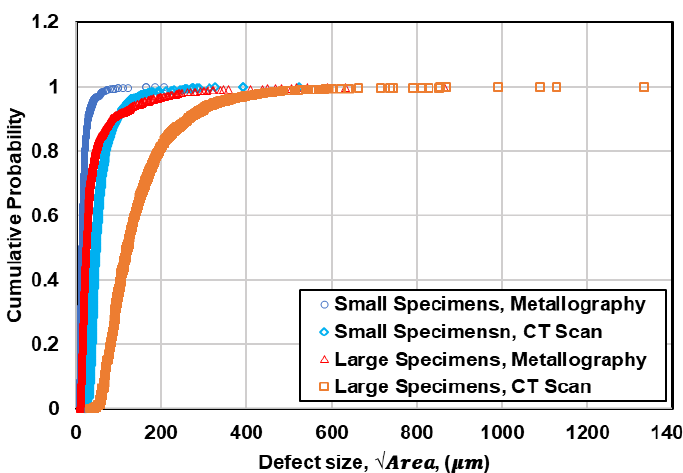
Figure 11. Comparison between defect distribution in small and large specimens using metallography and µCT data.